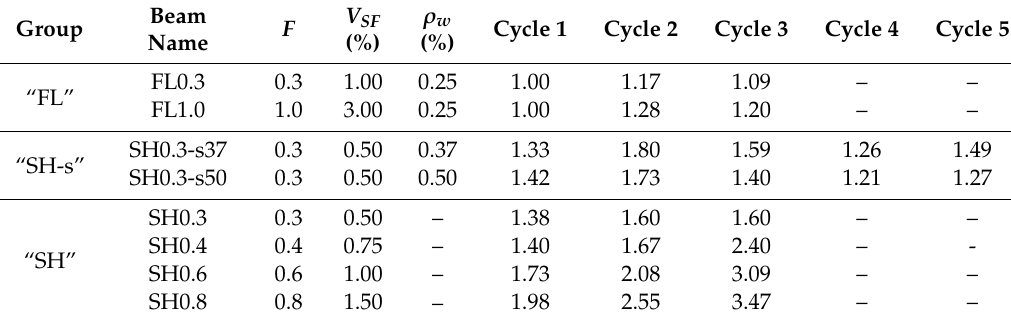
Figure 17. Influence of the steel fibers on the hysteretic and cracking behavior of the shear-critical beams with stirrups (group “SH-s” specimens). Table 9. Energy dissipation